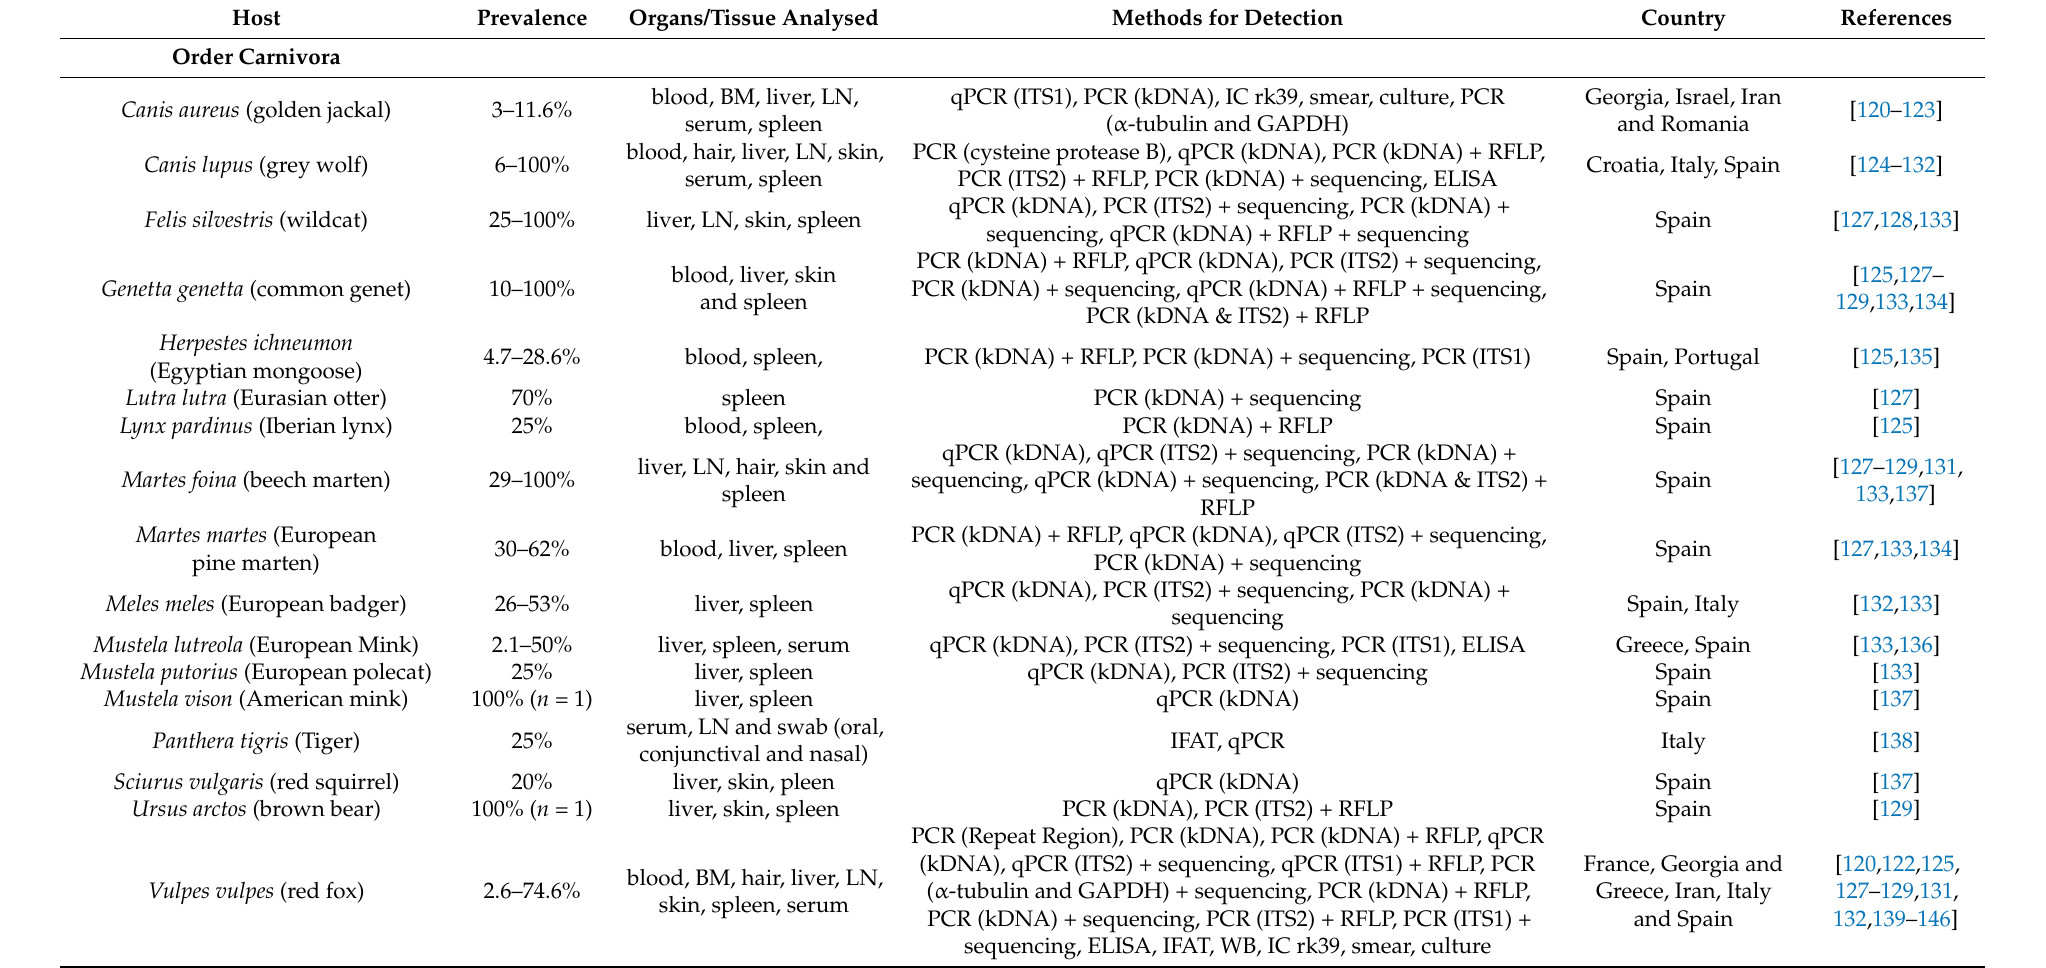
Table 6. Wild animals reported to be positive for L. infantum from Europe, Asia and Africa. Organs or tissues where the parasite was detected are indicated, as well as the techniques employed for